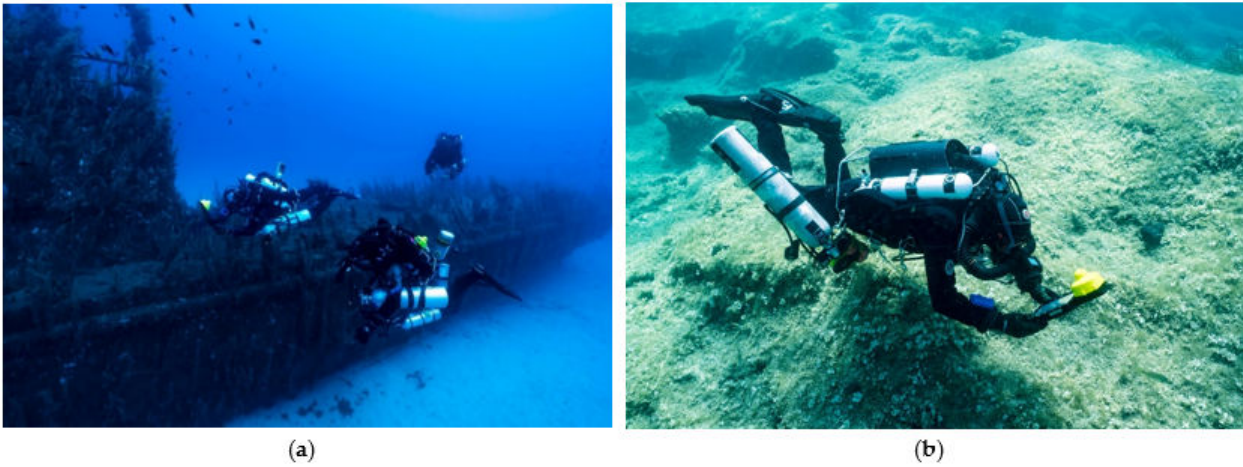
Figure 3. ( a ) CCR divers testing the UWIS system in Malta. ( b ) CCR diver training on UWIS system. © Heritage